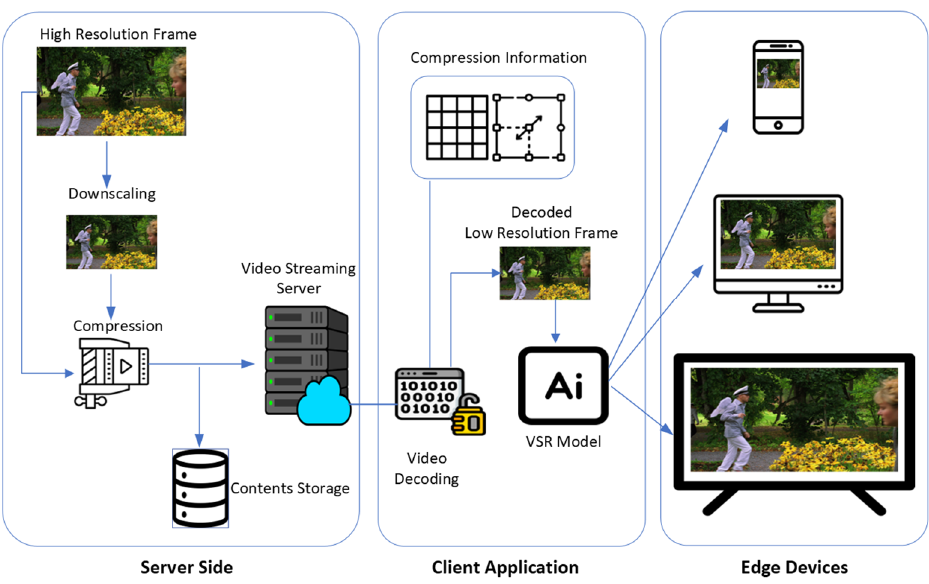
Figure 1. Overview of proposed method in video streaming service.